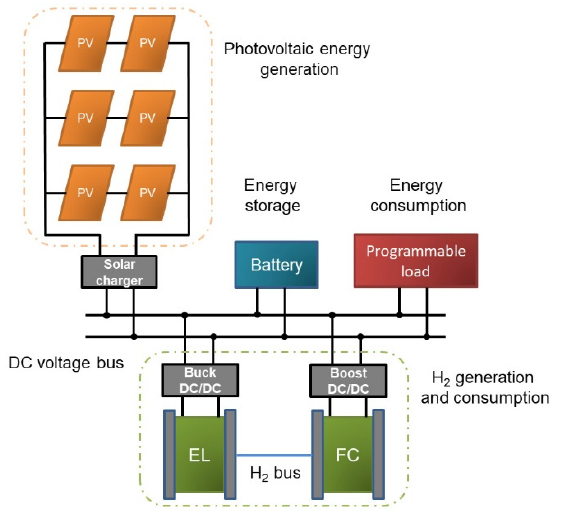
Figure 10. Block diagram of SMG where the PV modules are installed.